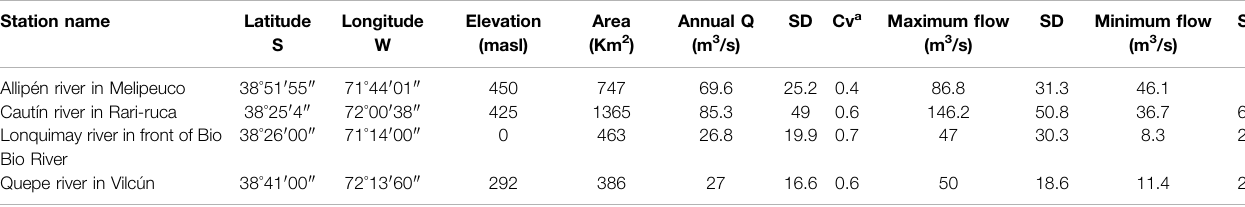
TABLE 3B | Results of the fl ows in each station: annual Q (m 3 /s); Coef fi cient of variation; max and min fl ows (m 3 /s) of the study